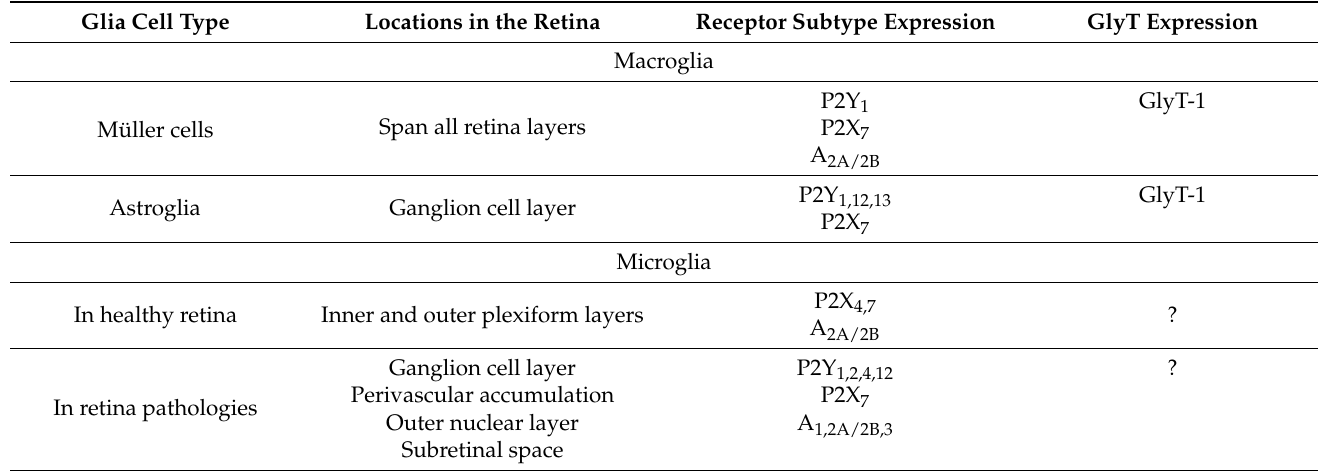
Table 3. Some characteristics of glia cells in the